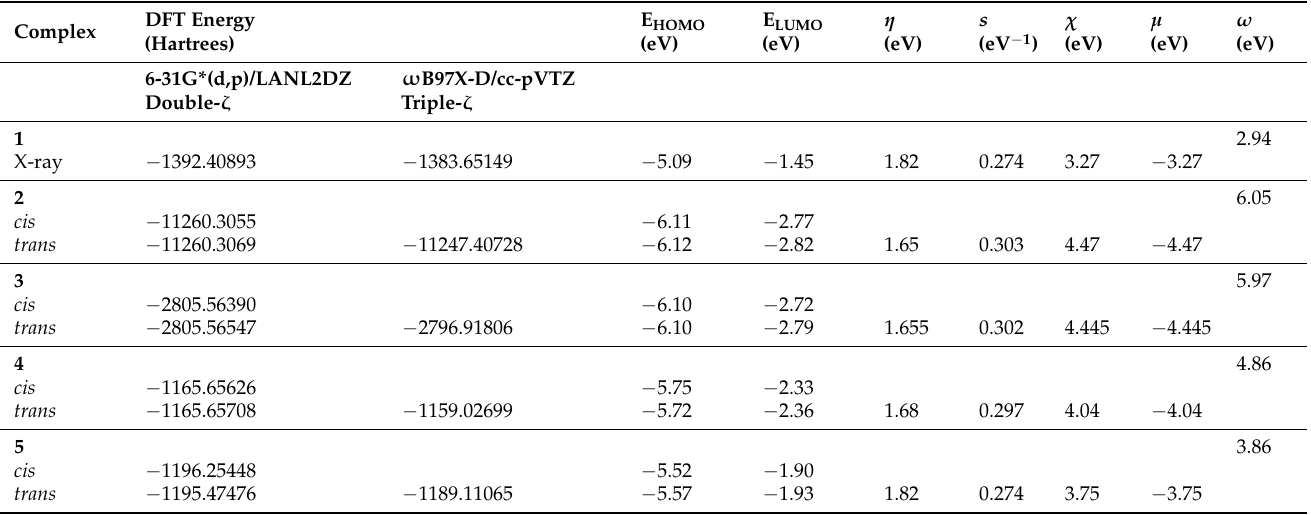
Table 8. DFT and FMOs energies and values of chemical global reactivity indices for complexes 1 – 5